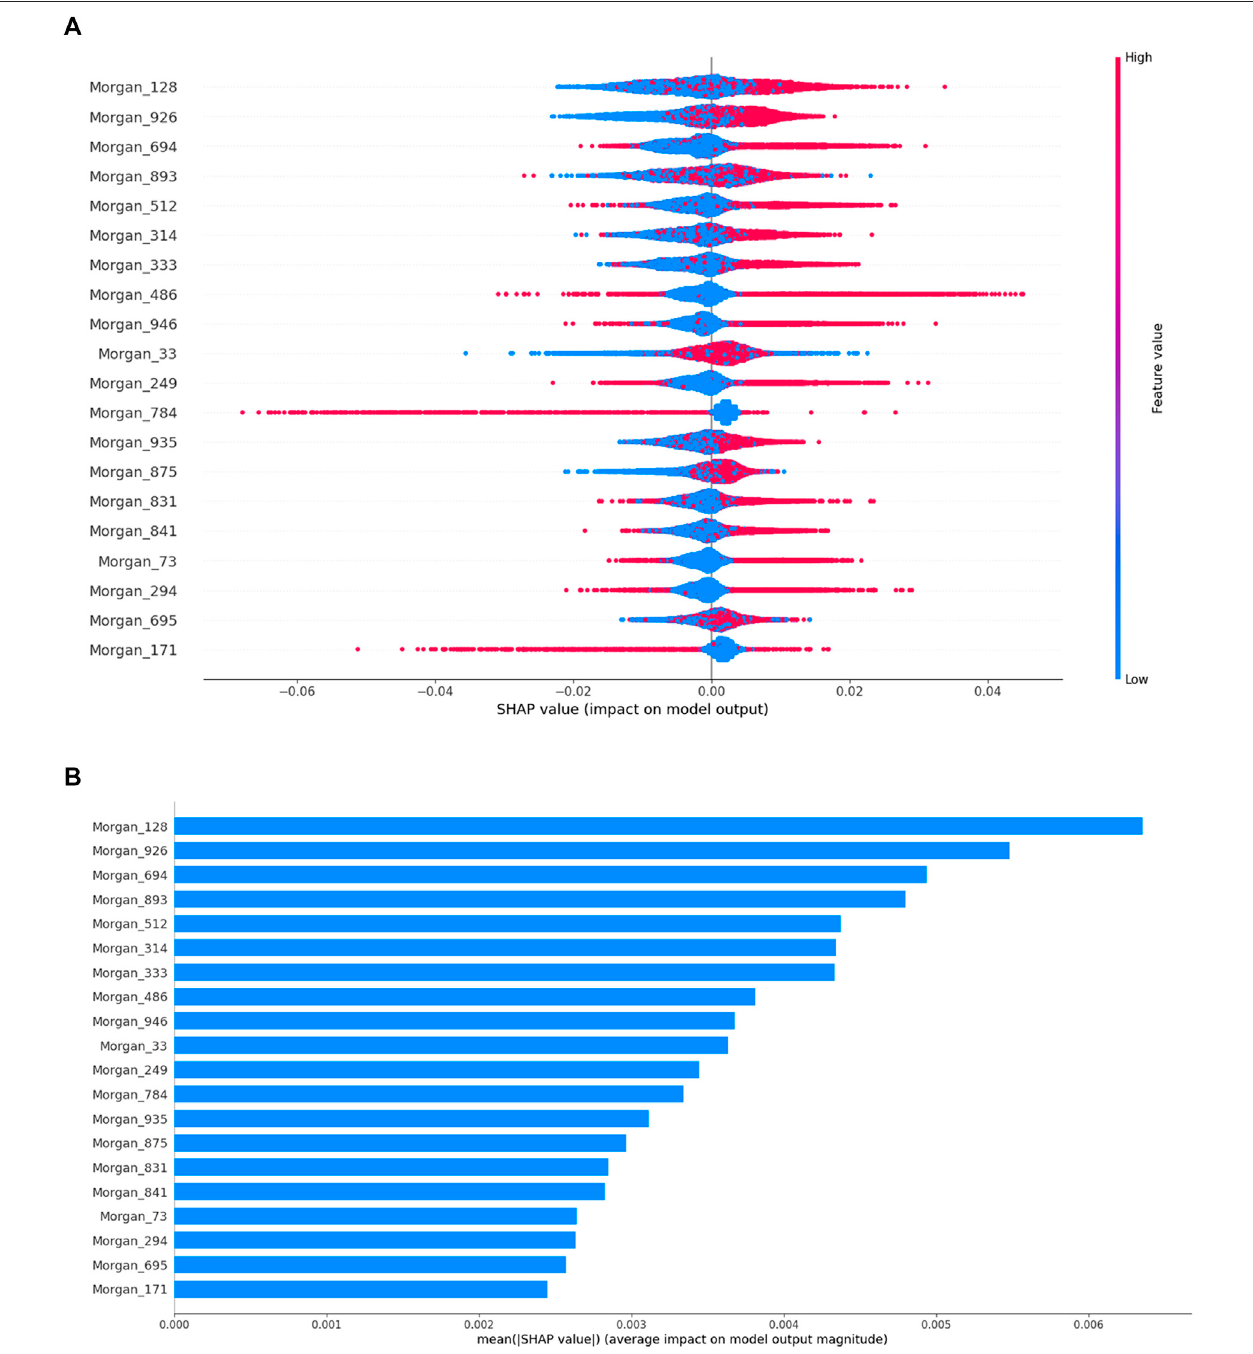
FIGURE8| Basedon thetop20mostimportantfeatures oftheRF:Morganmodel inMDA-MB-231, (A) theSHAP values foreach molecular substructure,and (B) the mean of the absolute value of the SHAP value for each molecular substructure.